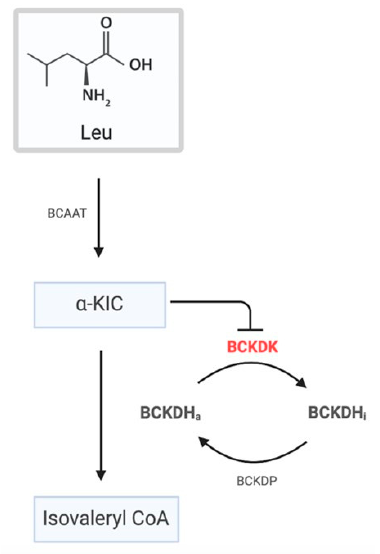
Figure 2. Schematic representation of the regulation of BCKDC. BCAAs undergo a transamination reaction by BCAAT. The resulting α -ketoacids are then oxidatively decarboxylated by BCKDH. The overall activity of BCKDH is regulated by phosphorylation/dephosphorylation by BCKDK and DCKDP, respectively. On its turn, BDKDK is negatively regulated by the α -ketoacids, leading to an increase in the activation of BCKDH (dephosphorylated state).